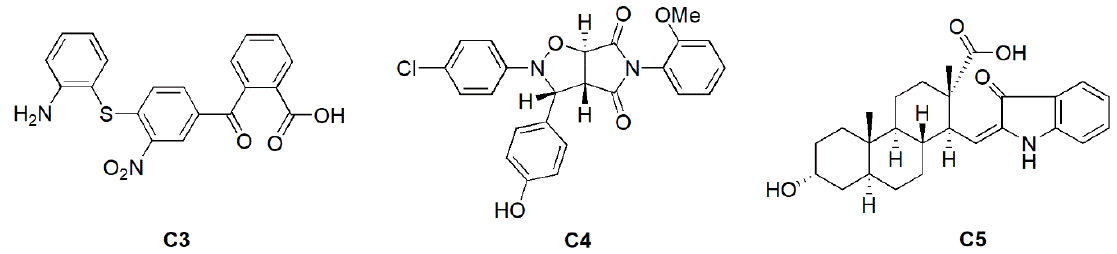
Figure 2. Three hit compounds C3 , C4 , and C5 previously identified by in silico screening.